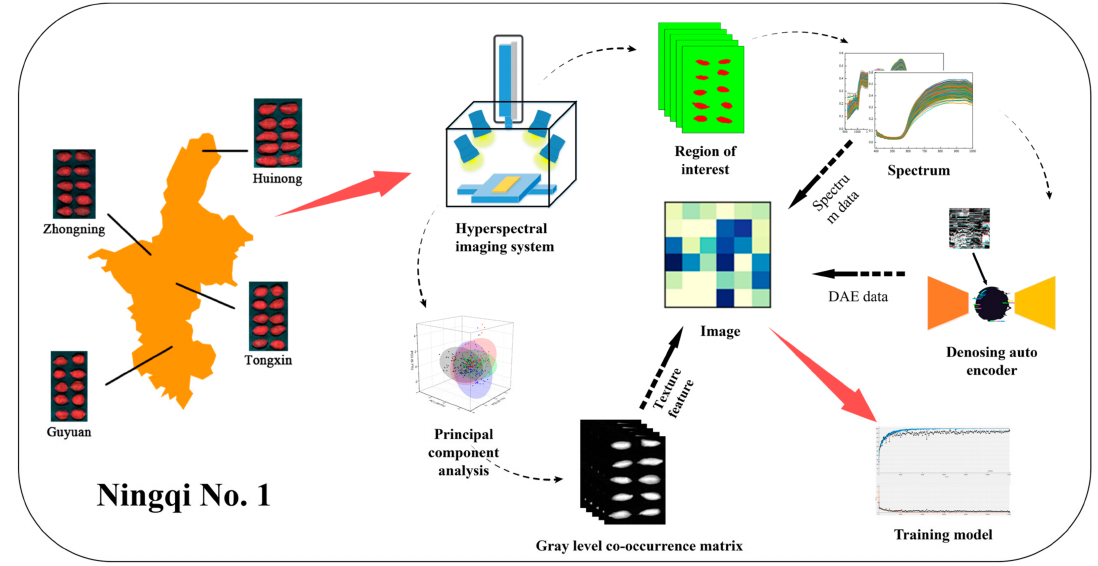
Figure 1. Flowchart of key steps in this